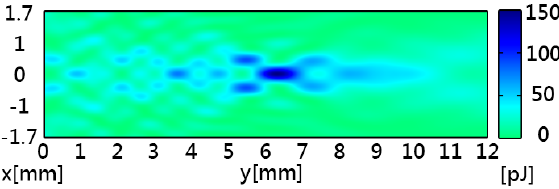
Figure 4. Simulated acoustic potential energy of the acoustic tweezers. The blue regions correspond to high-potential-energy regions, while the green regions correspond to zero-energy regions.